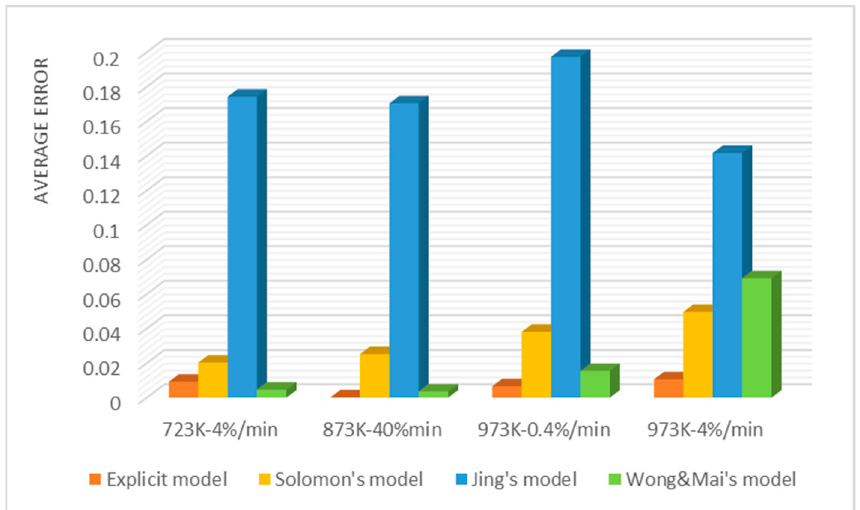
Figure 11. Average error for predicted life given by the explicit model, Solomon’s model, Jing’s model, and Wong & Mai’s model.